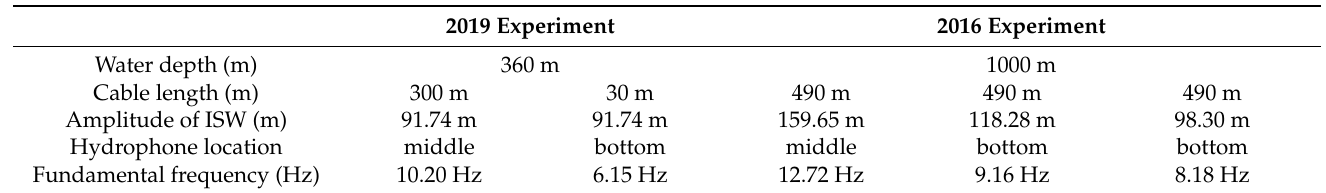
Table 4. The comparison between ISW observations in the 2016 experiment and 2019